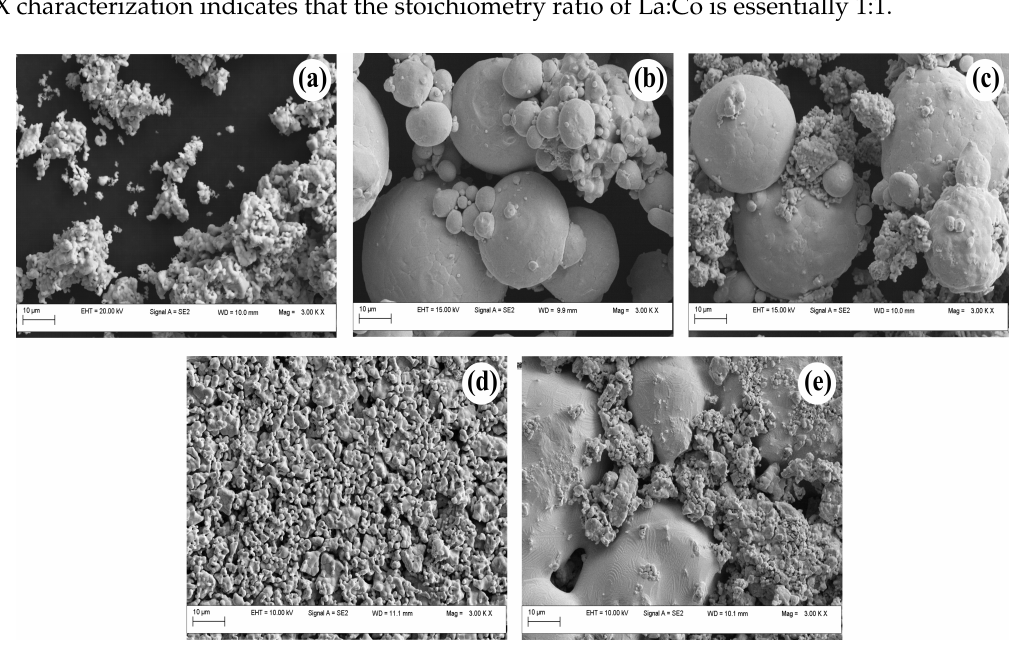
Figure 2. SEM images of Ag, LaCoO 3 and mixed Ag-LaCoO 3 powders and pre-sintered pellets: ( a ) perovskite LaCoO 3 powders obtained by solid-state synthesis from lanthanum and cobalt oxide precursors at 1000 ◦ C for 8 h in air; ( b ) micrograph of the Ag powders used in this work; ( c ) mixed ALCO5 powders prepared at room temperature; and ( d , e ) micrographs of porous LaCoO 3 and ALCO5 pellets sintered at 1000 ◦ C for 3 h and 1 h,